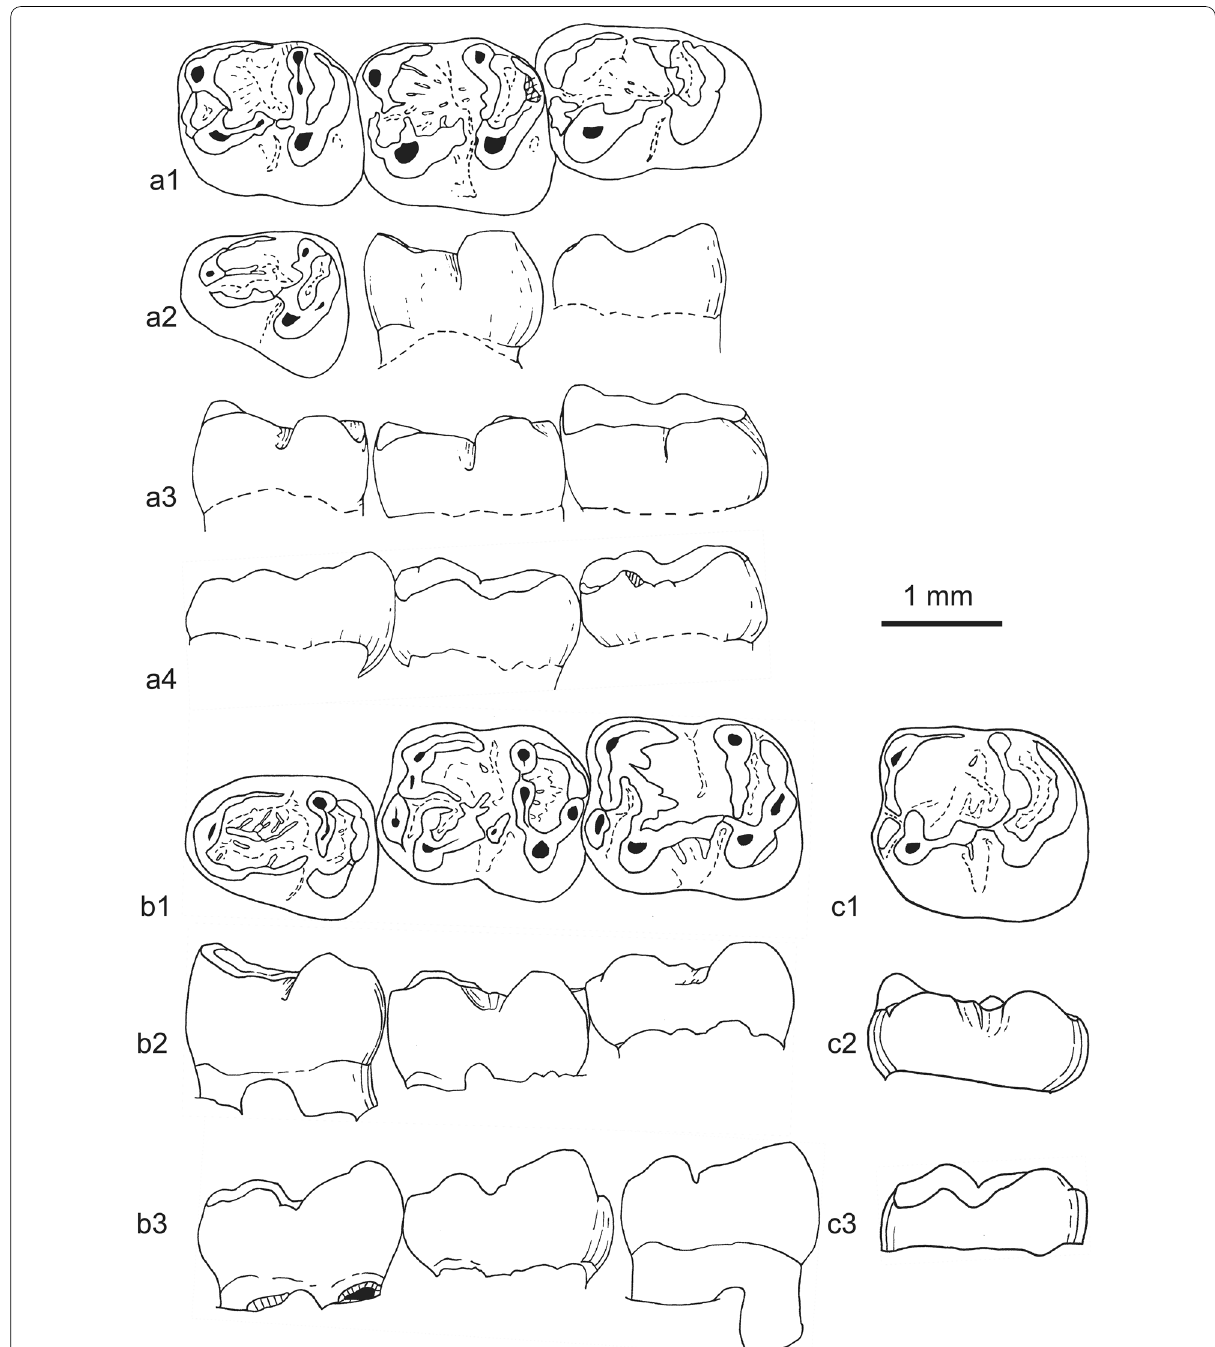
Fig. 10 a Lower tooth row of Protadelomys cartieri (Stehlin & Schaub, 1951), from Egerkingen (Swiss Jura); Ek 248, left p4–m3; a1, m2–m3, occlusal view; a2, p4, first, occlusal view, second buccal aspect; third, lingual aspect. b Lower tooth row, Protadelomys sp. indet., from Egerkingen (Swiss Jura); Ek 250, left p4–m2; b1, occlusal view; b2, buccal aspect; b3, lingual aspect. Scale bar